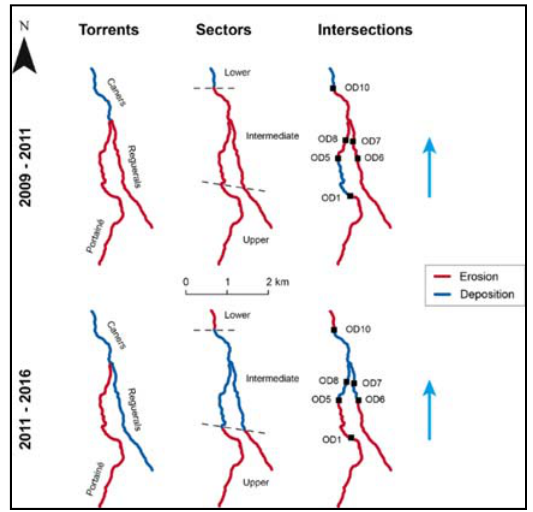
Figure 11. Sediment budget segregation by dividing the channels according to different criteria: drainage network (torrents), mean channel gradient (catchment sectors) and road intersections. Blue arrows indicate flow direction.